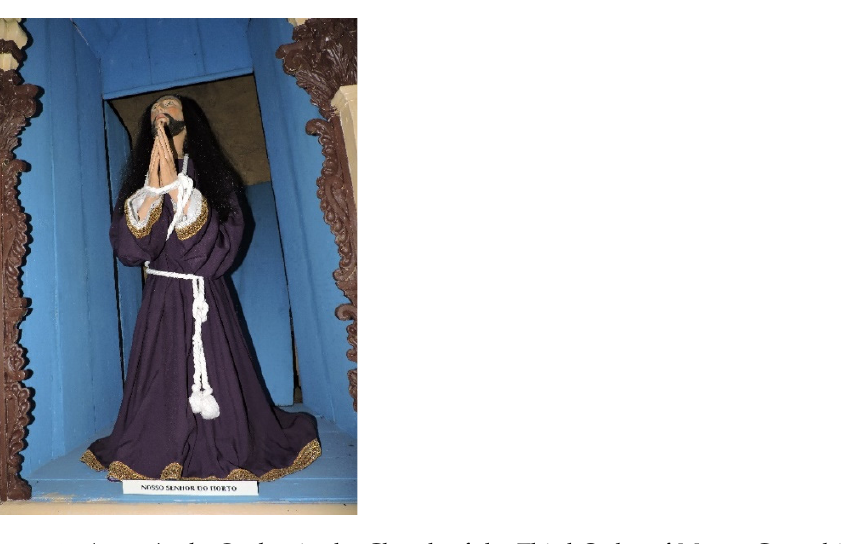
Figure 4. Agony in the Garden , in the Church of the Third Order of Mount Carmel in Mogi das Cruzes. Polychrome wood sculpture (116 × 40 × 57cm), eighteenth century. Photo by Lia Brusadin, 1 January 2017.